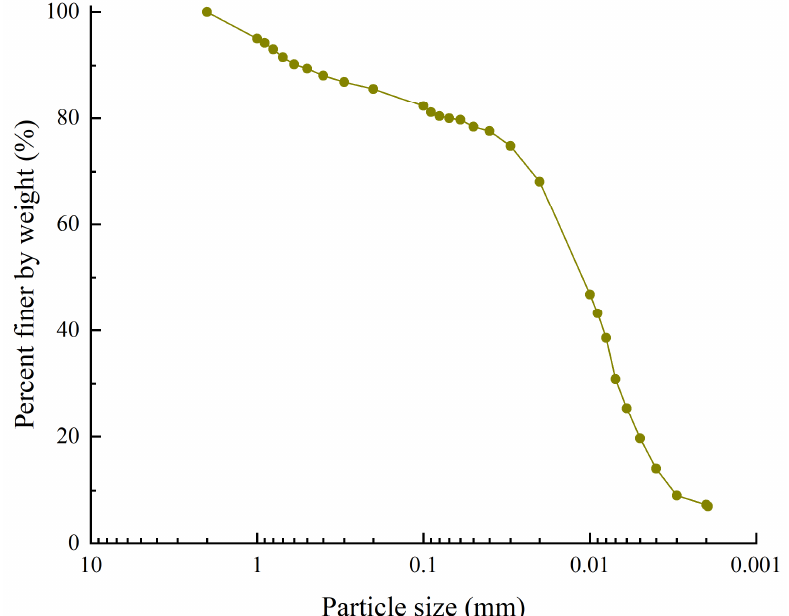
Figure 5. The particle size distribution of the sliding zone soil.